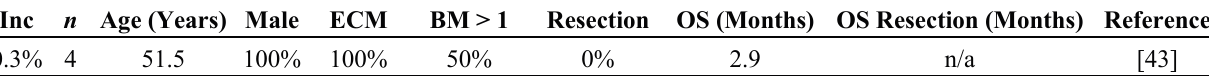
Table 4. Clinical studies analyzing characteristics and survival of patients diagnosed with brain metastases originating from pancreatic cancer.